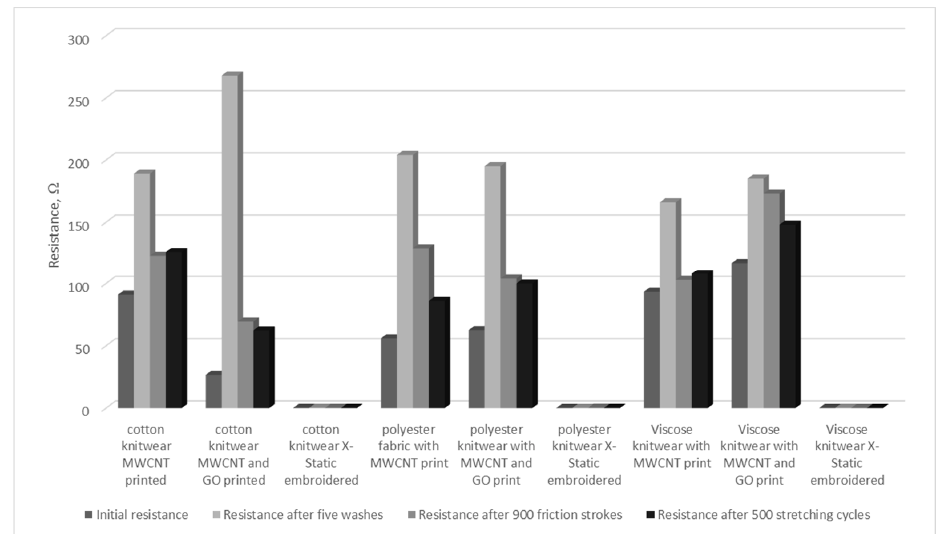
Figure 3. Dependence of changes in the surface resistance in the produced electrodes.